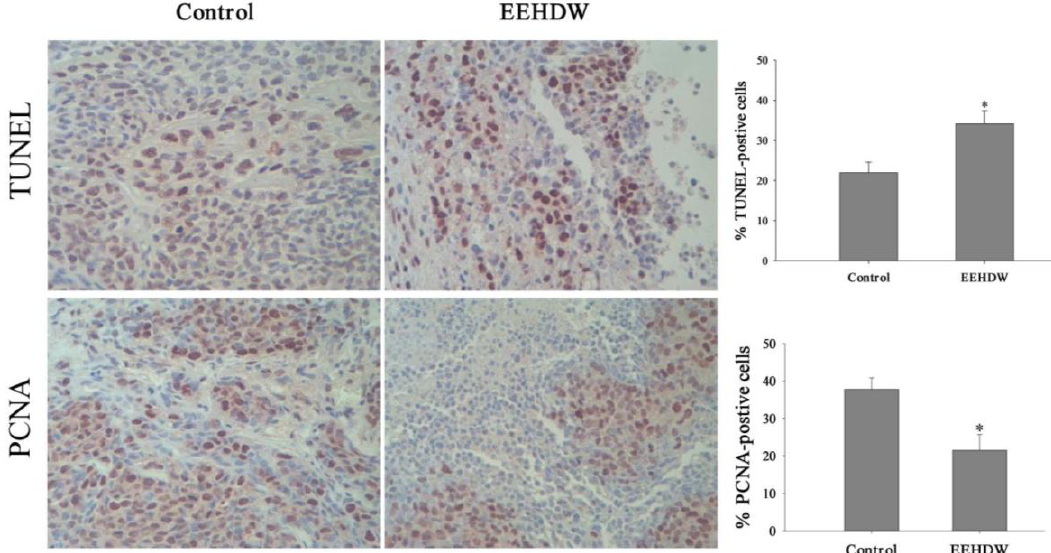
of the experiment, tumor tissues were processed for immunohistochemical (IHC) staining for TUNEL (top) or PCNA (bottom). Left: The photographs are representative images taken at a magnification of 400×. Right: Quantification of IHC assay is represented as percentage of positively-stained cells. Data shown are averages with SD (error bars) from 10 individual mice in each group. * p  0.01, versus